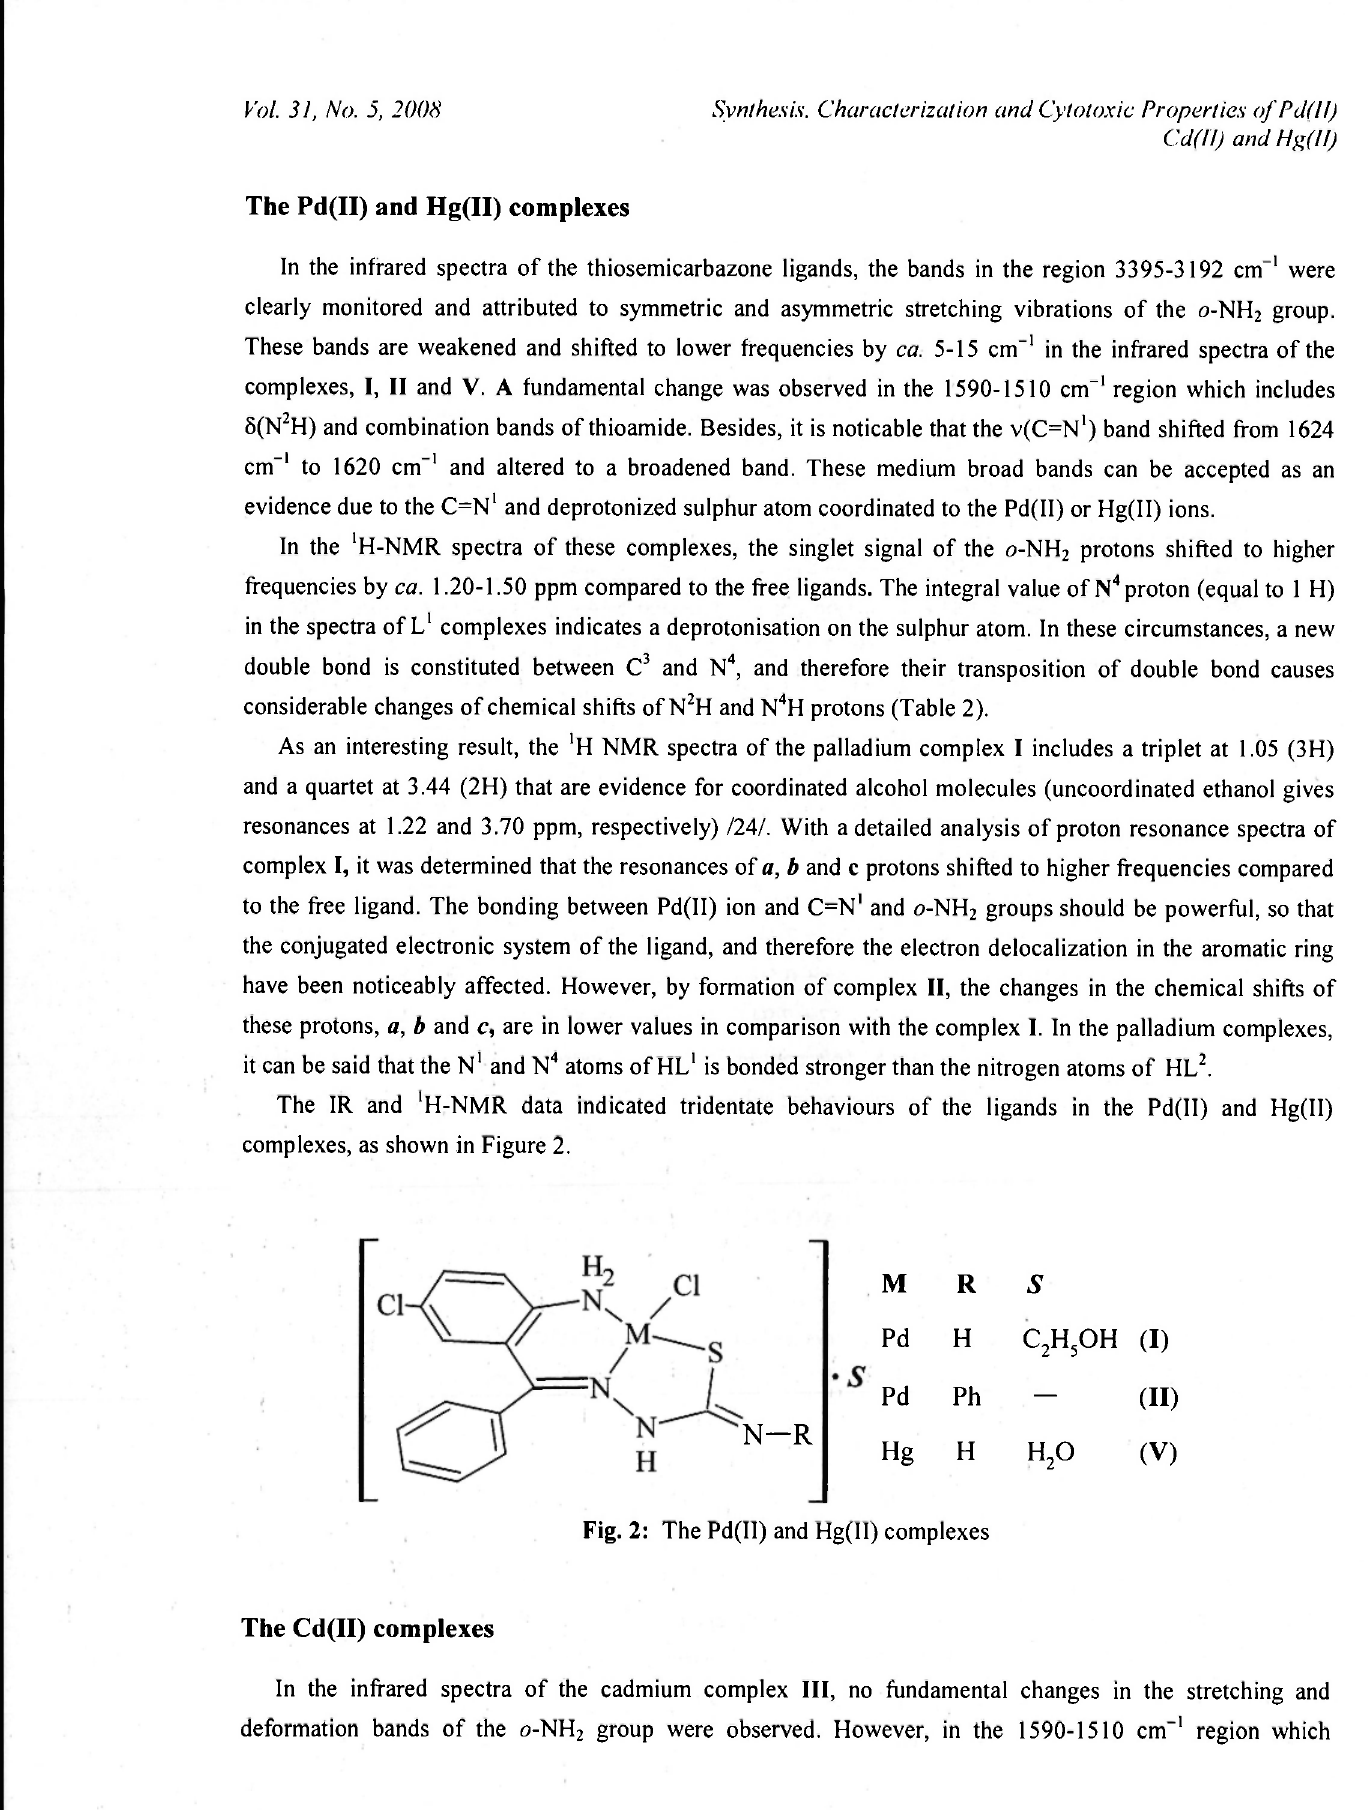
Fig. 2: The Pd(II) and Hg(II)